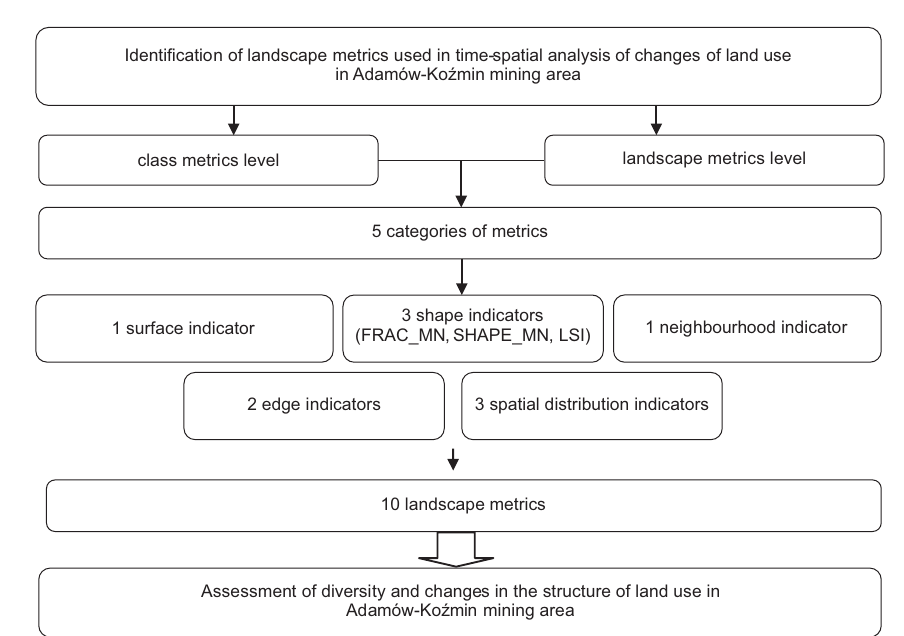
Fig. 3. Landscape metrics used in the analysis of land use changes in the Adamów-Koźmin mining area. Source: own